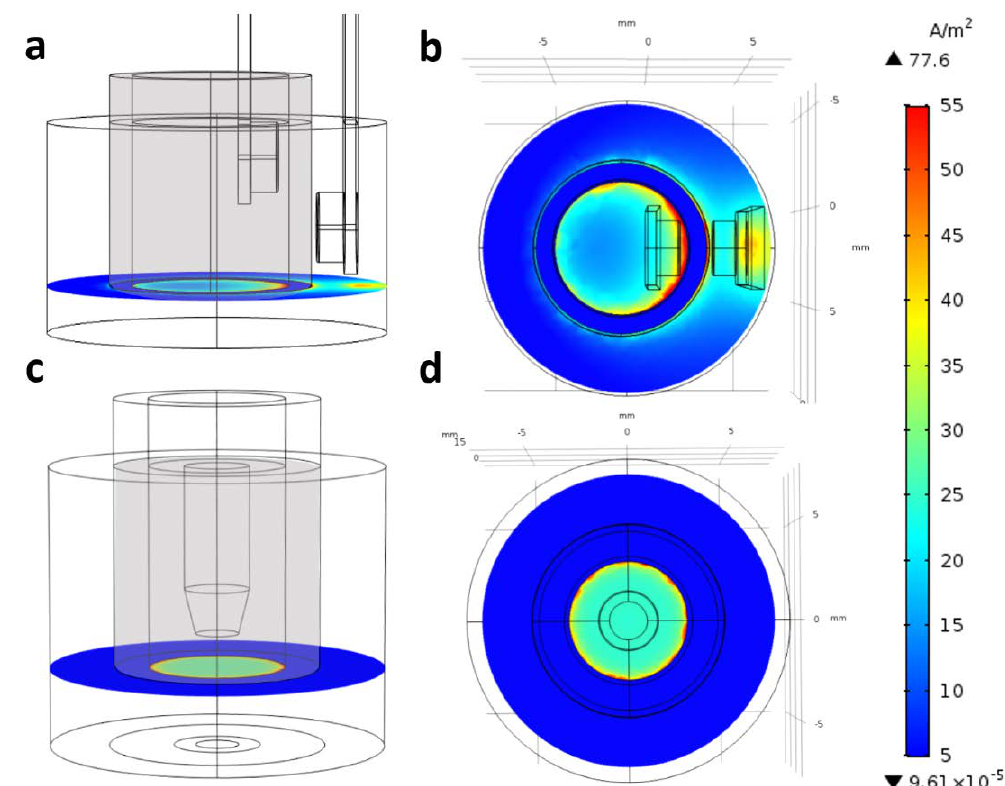
Figure 6. COMSOL modeling of electrical resistance measurement across culture inserts (diameter: 6.5 mm, 24-well type) with ( a , b ) chopstick (STX2) or ( c , d ) chamber electrodes. The thin black lines show the borders of the objects and their components (borders of the electrodes on the surface), while the grid behind is to indicate the actual size of the objects. For easier understanding, the optically transparent cylindrical wall of the inserts is depicted in gray. The current density was calculated and is shown at the level of the cell layer at the bottom of culture inserts.